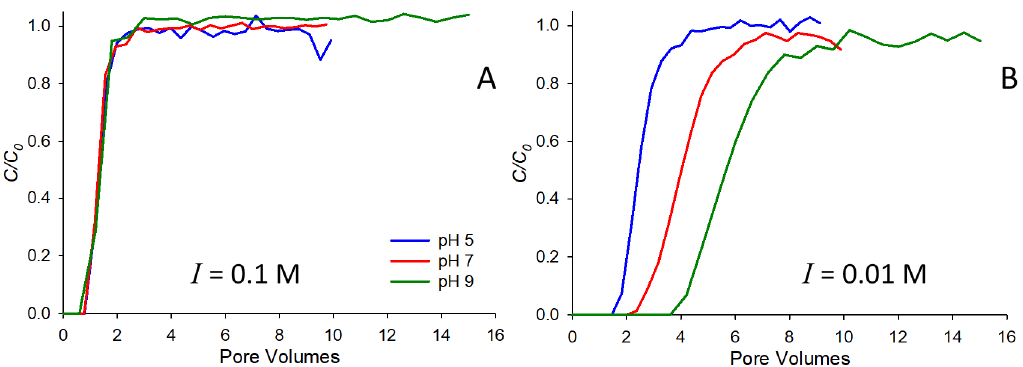
Figure 1. Breakthrough curves for 10 −4 M Sr in 0.1 M ( A ) and 0.01 M ( B ) NaNO 3 . Experiments conducted at pH 5, 7, and 9 are shown.